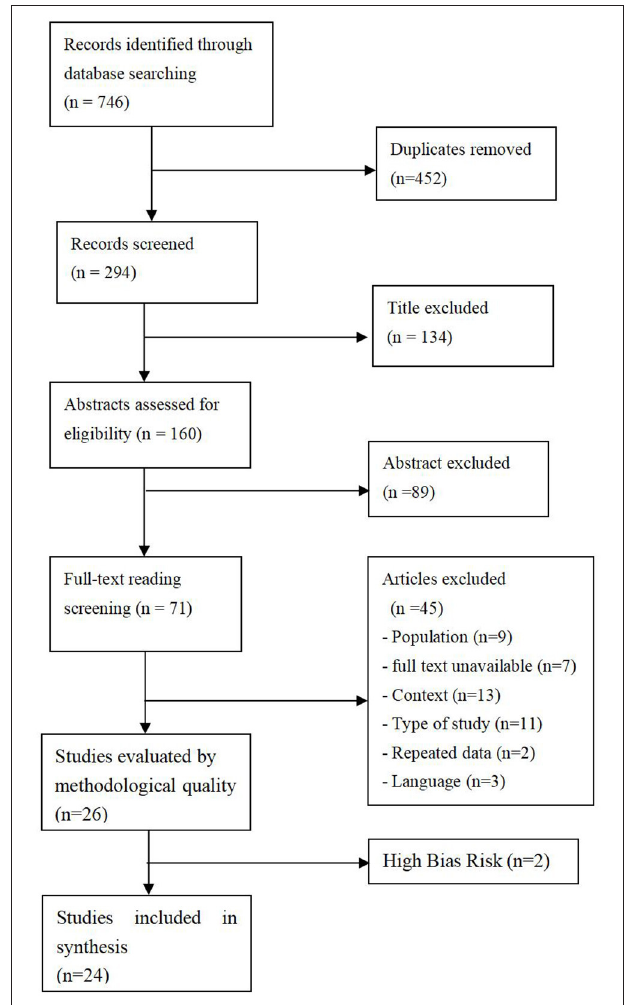
FIGURE 1 | Eligibility and screening of studies considered for the systematic